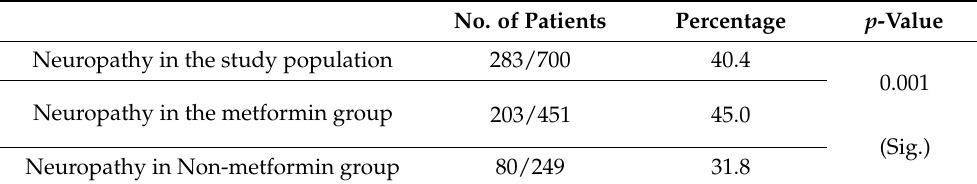
Table 6. Prevalence of clinical neuropathy in different